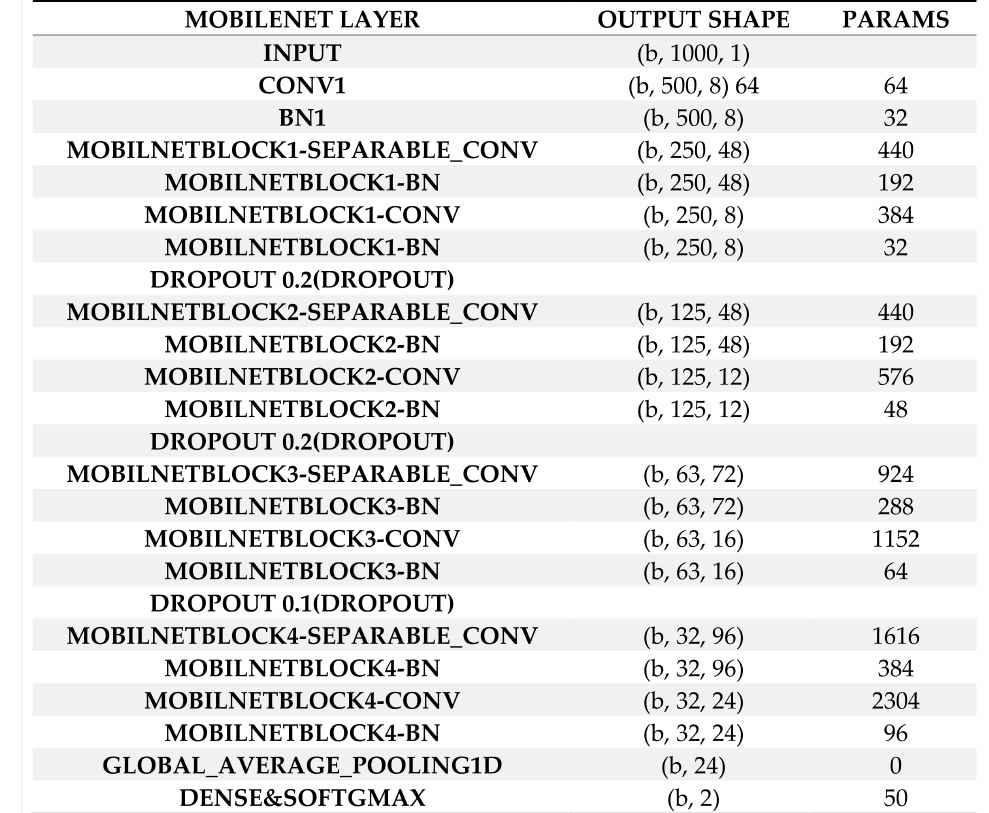
Figure 3. Mobilenet Architecture. Note: BN Batch Normalization, CONV Convolution, PARAMS